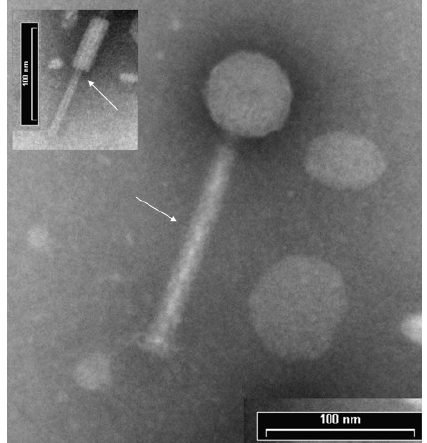
Figure 1. Transmission Electron Microscopy (TEM) of bacteriophage ΦPan70. TEM micrographs of negatively stained phage ΦPan70 showing an isometric head structure with a diameter of ~58 nm and a tail of 148 nm consisting of a neck, a contractile sheath and a central tube. The morphology of ΦPan70 corresponds to the Myoviridae family. Arrows show the extended tail sheath and, in the insert, the internal tube when the tail sheath is retracted.